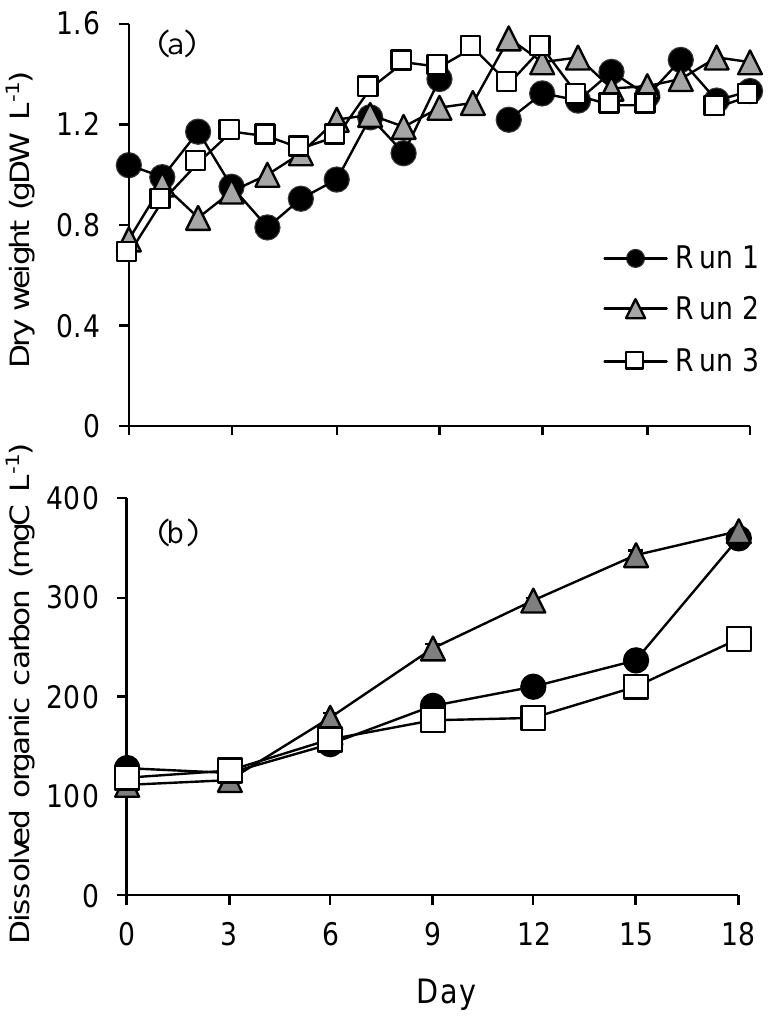
Figure 4. Photosynthesis-based products in the photobioreactors: ( a ) algal growth and ( b ) dissolved organic carbon.